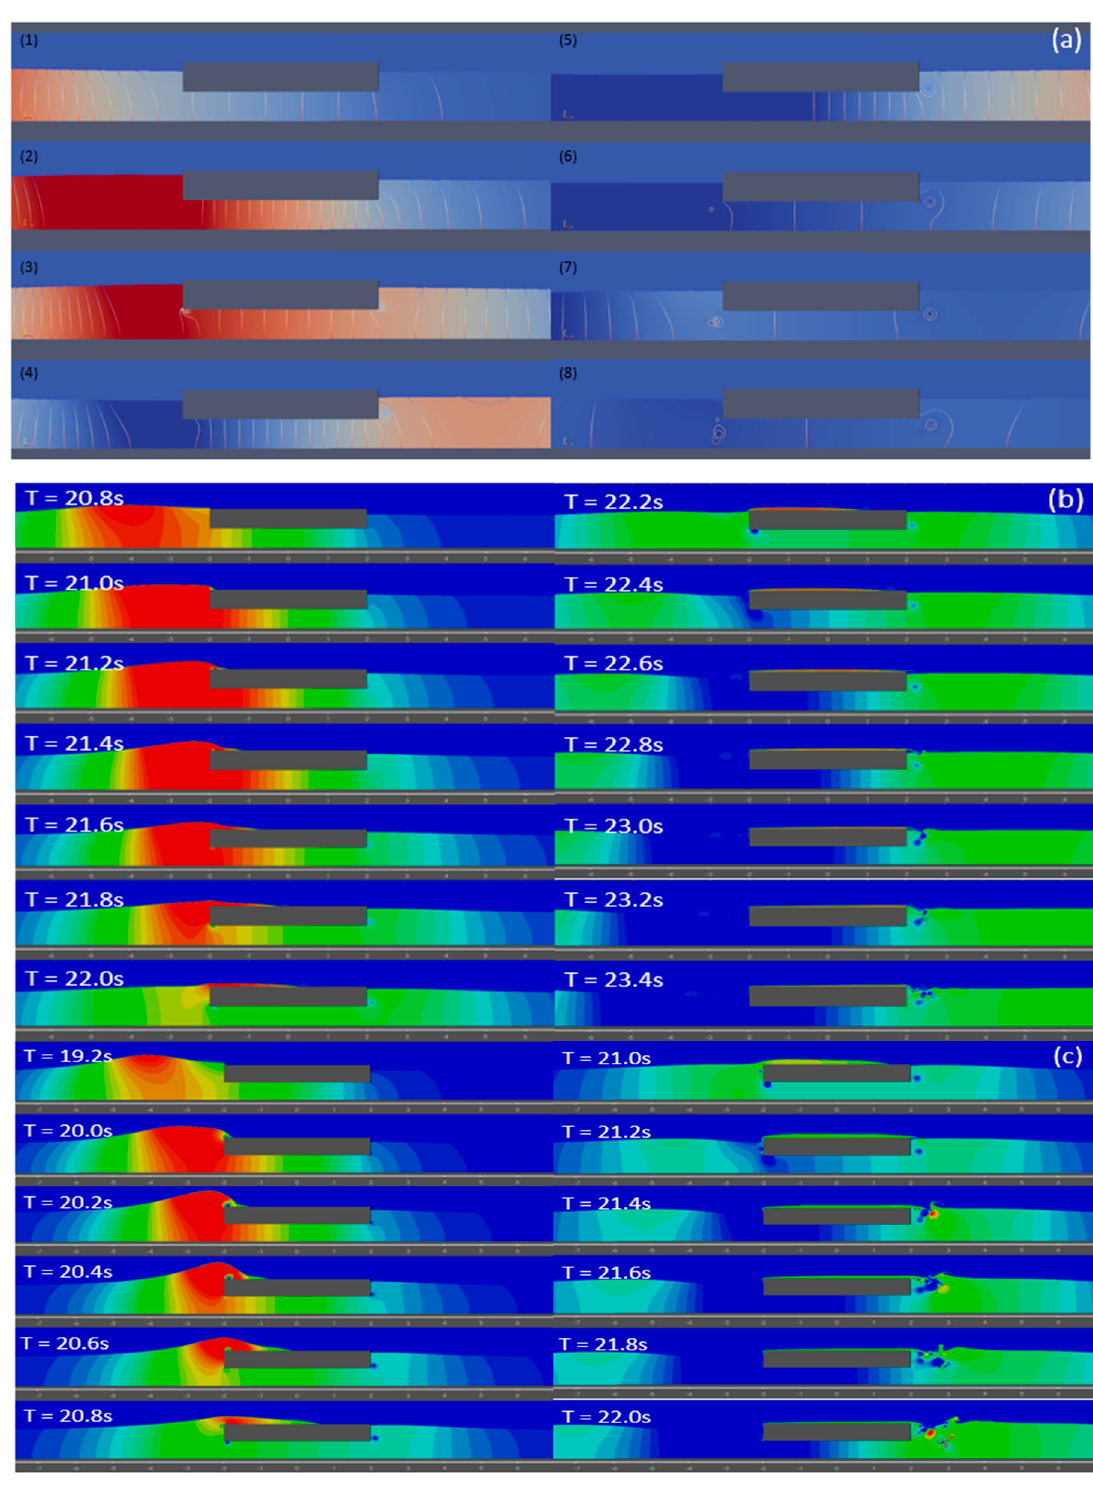
Figure 12. Pressure distribution around the pontoon during the wave encounter in the fluid domain, while the solitary wave interacts with the fixed pontoon; ( a ) a / h = 0.1, ( b ) a / h = 0.3, and ( c ) a / h =